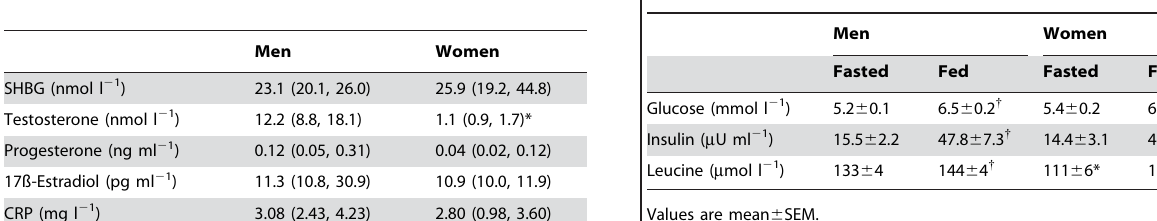
Table 2. Plasma sex hormone and CRP concentrations.